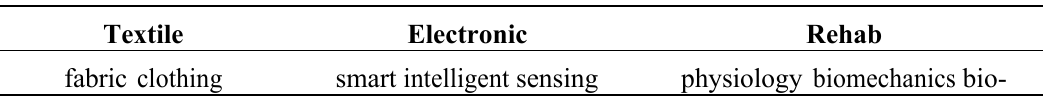
Table 2. Terms used in literature